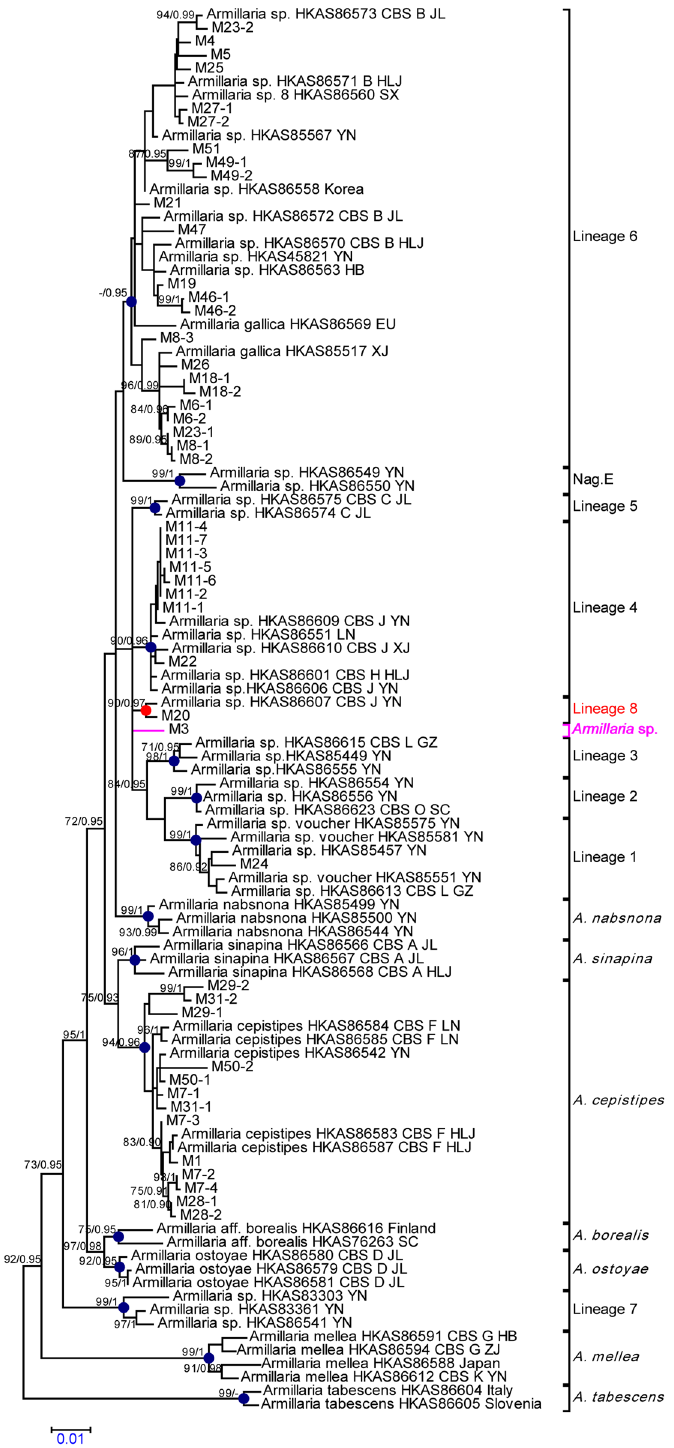
Figure 1. Phylogenetic tree generated from the three-locus (ITS, EF1- α and β -tubulin) data set. The blue labels on the nodes of the phylogram indicate phylogenetic lineages recognized by Guo et al . 12 . The red labels on the nodes of the phylogram indicate the new lineage (lineage 8) recognized in this research. The pink line represents the singleton. The values of the bootstrap frequencies of ML (BP > 70%) and posterior probability (PP > 0.90) are shown above the nodes. Armillaria isolates generated from this research are presented as M followed by a